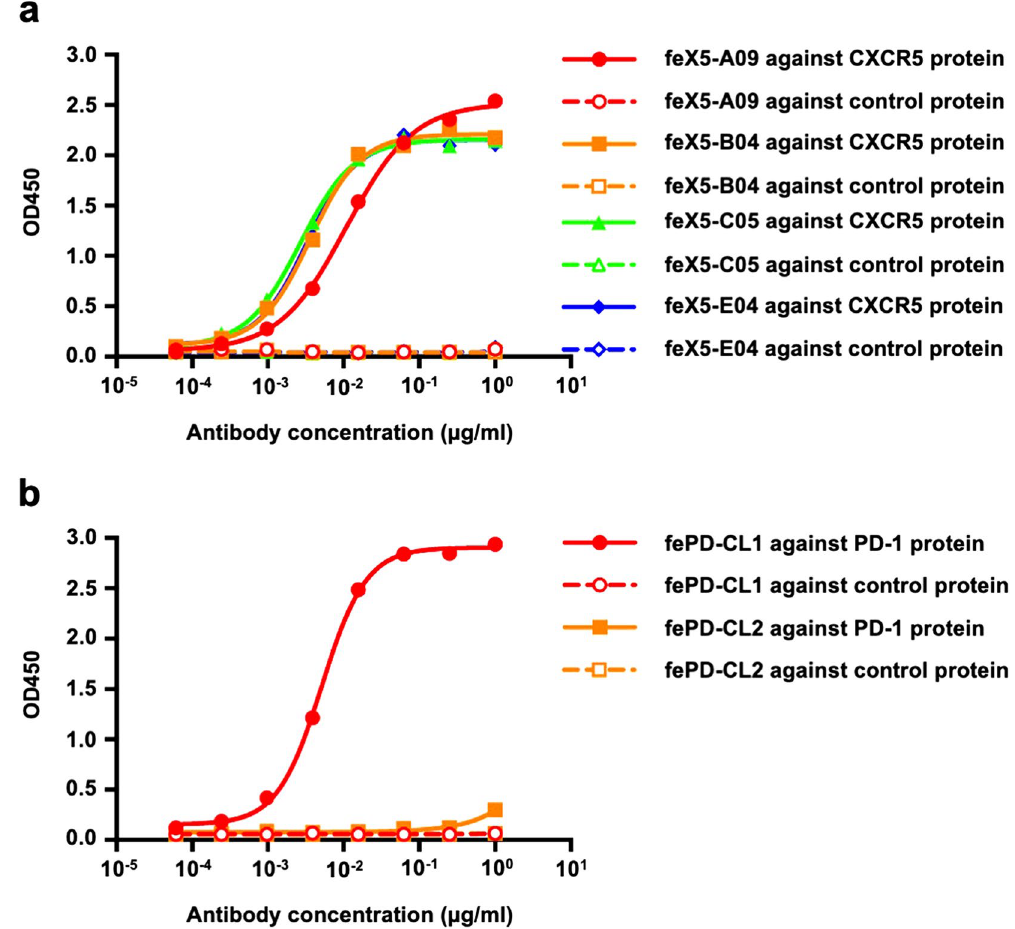
Figure 3. Binding activity of anti-CXCR5 and PD-1 antibodies with autologous and control antigens. ( a ) Binding activity of anti-ferret CXCR5 clone A09 (feX5-A09), B04 (feX5-B04), C05 (feX5-C05) and E04 (feX5-E04) against recombinant ferret CXCR5 protein or an irrelevant control protein with the same Fc tag. ( b ) Binding activity of anti-ferret PD-1 clone CL1 (fePD-CL1) and CL2 (fePD-CL2) against recombinant ferret PD-1 protein or an irrelevant control protein with the same Fc